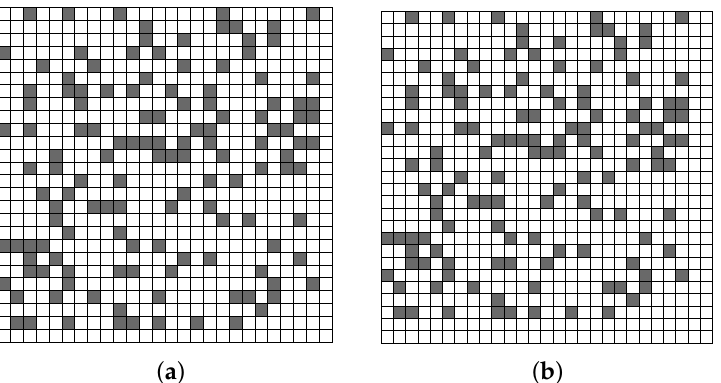
Figure 6. Data of grid. ( a , b ) is different pre-processing results with different CKMs, there is one more blank row and column a than that of b . ( a ) Pre-processing data grid with 2 × 2 kernel. ( b ) Pre- processing data grid with 3 × 3 kernel.